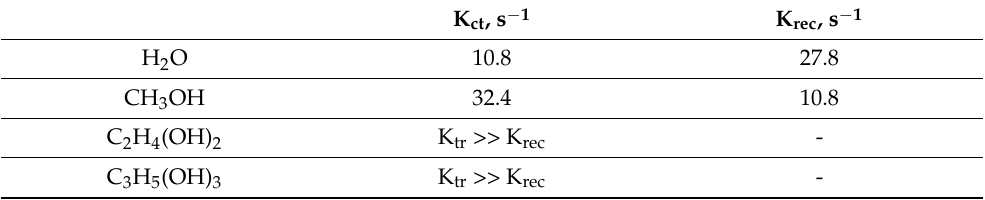
Table 1. Charge transfer and recombination constants at E = 0.4 V vs. Ag on film photoanode Ti 4+ /Fe 2 O 3 /FTO under monochromatic illumination at 452 nm, with a 14 mW cm − 2 power density in aqueous solutions of 0.1 M KOH, 0.1 M KOH + 20% CH 3 OH, and 0.1 M KOH + 20% C 3 H 5 (OH) 3